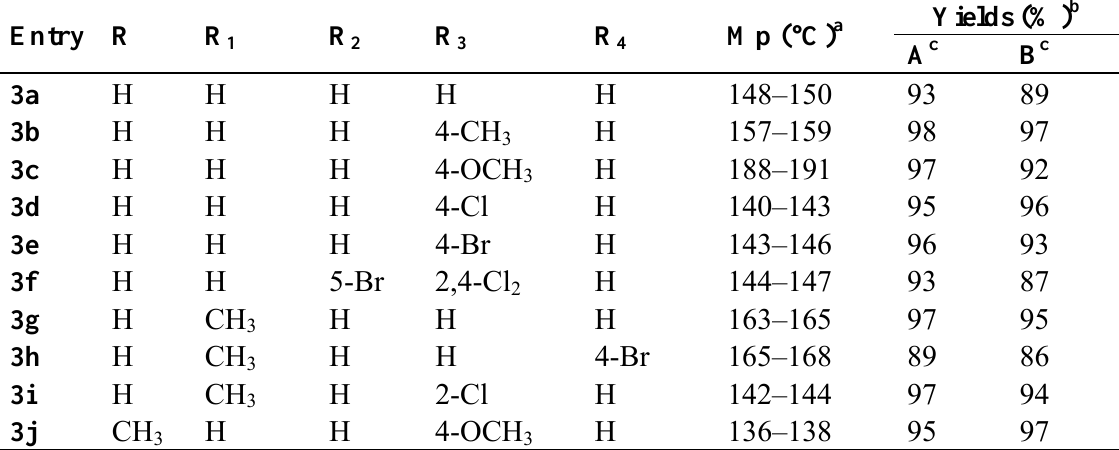
]-catalyzed synthesis of 1-aryl-3-(indole-3-yl)-3-(2-aryl-1,2,3- 4